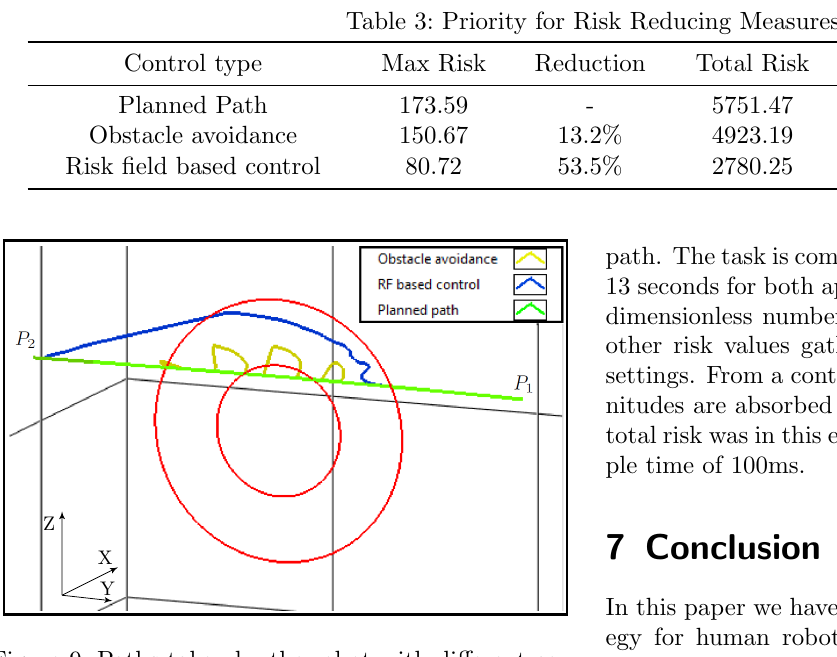
Figure 9: Paths taken by the robot with different con- trol strategies.